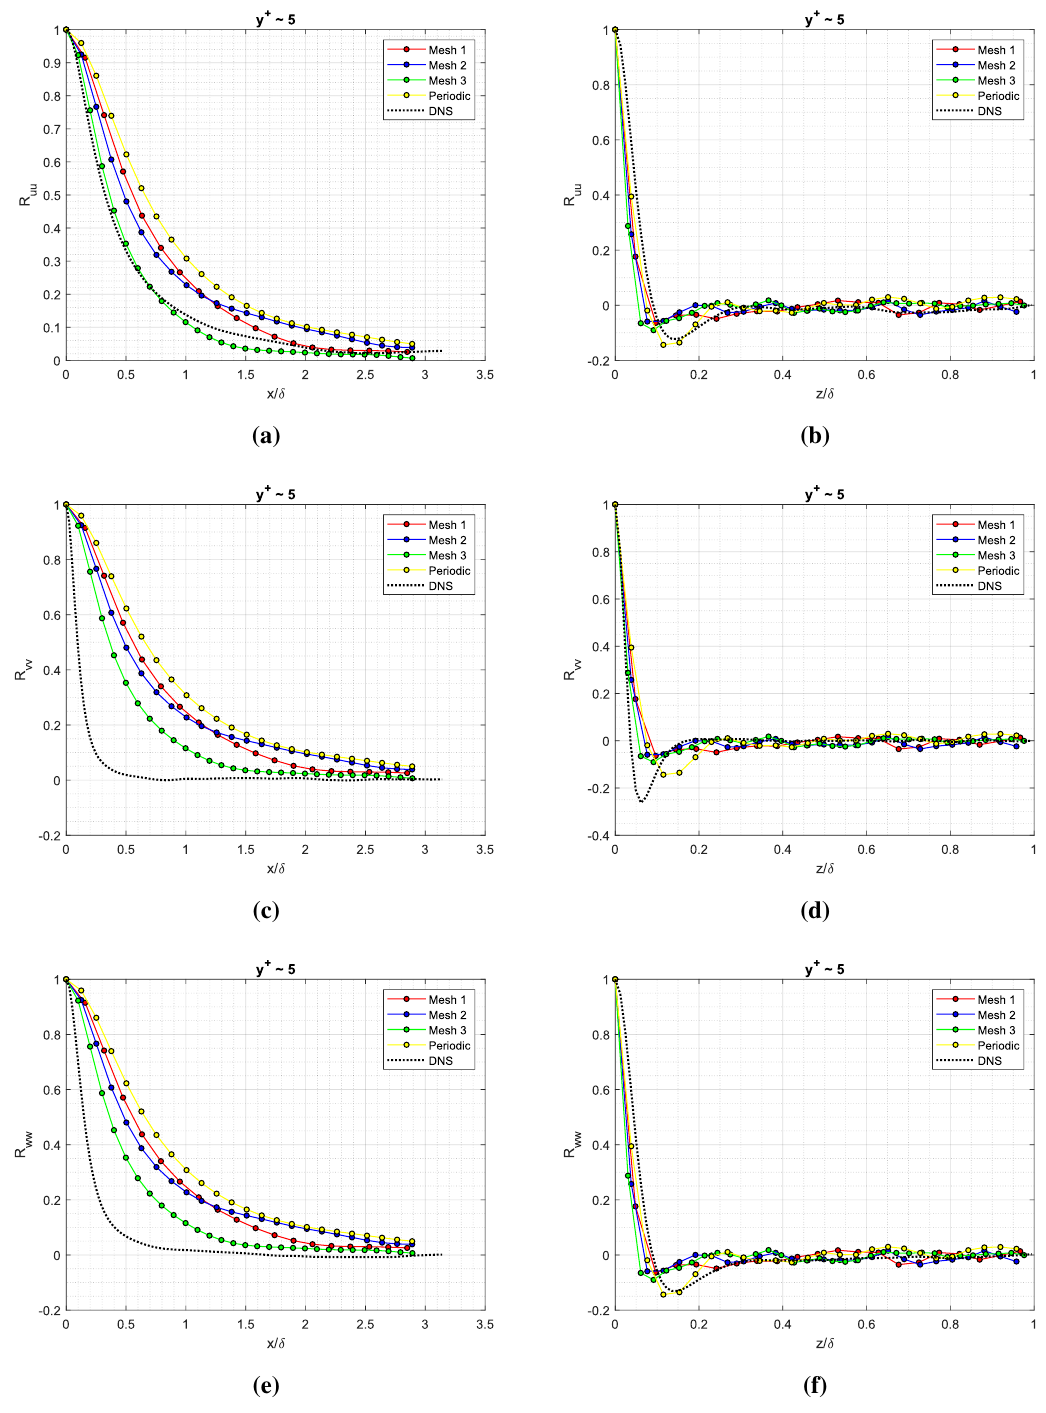
Figure 5: Spatial autocorrelation of velocity components at y + = 5 Figure 5. Spatial autocorrelation of velocity components at y + = 5: stream-wise velocity along ( a ) x and ( b ) z directions, wall-normal velocity along ( c ) x and ( d ) z directions, span-wise velocity along ( e ) x and ( f ) z